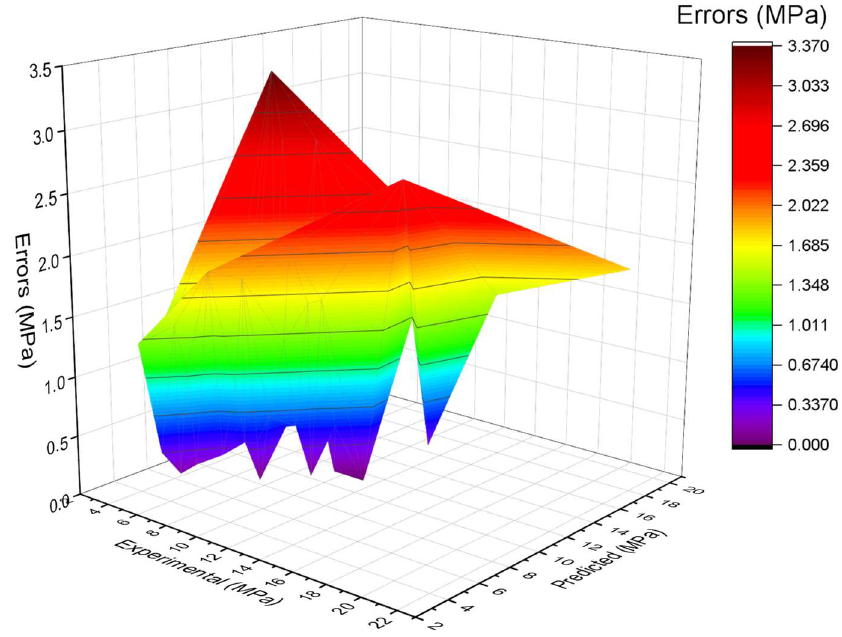
Figure 9. Estimated gradient boosting and experimental values, with errors.